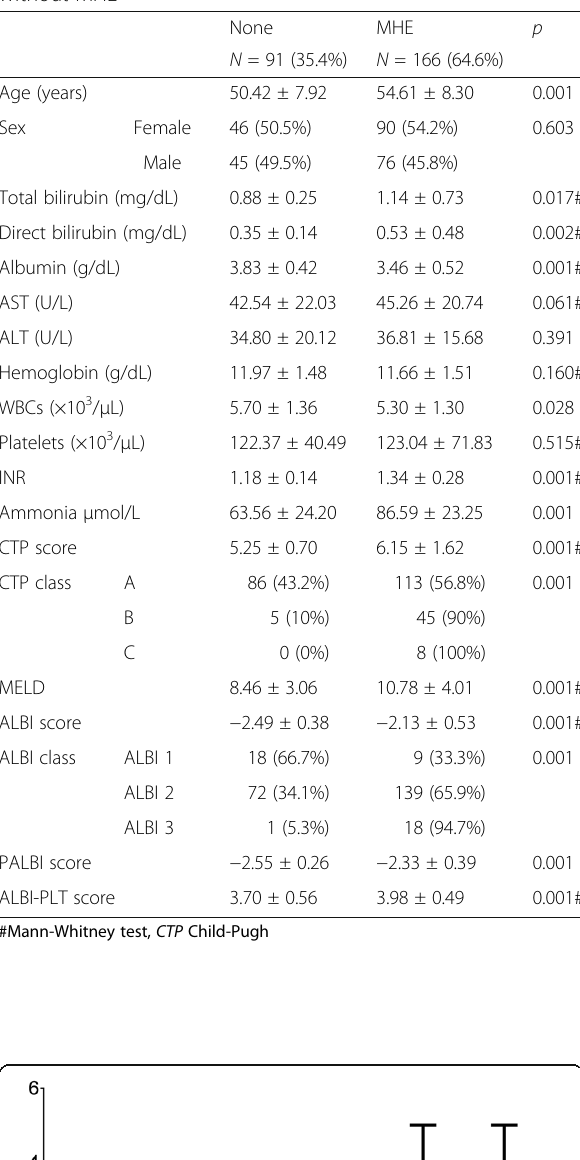
Table 1 Comparison of the baseline data of patient with and without